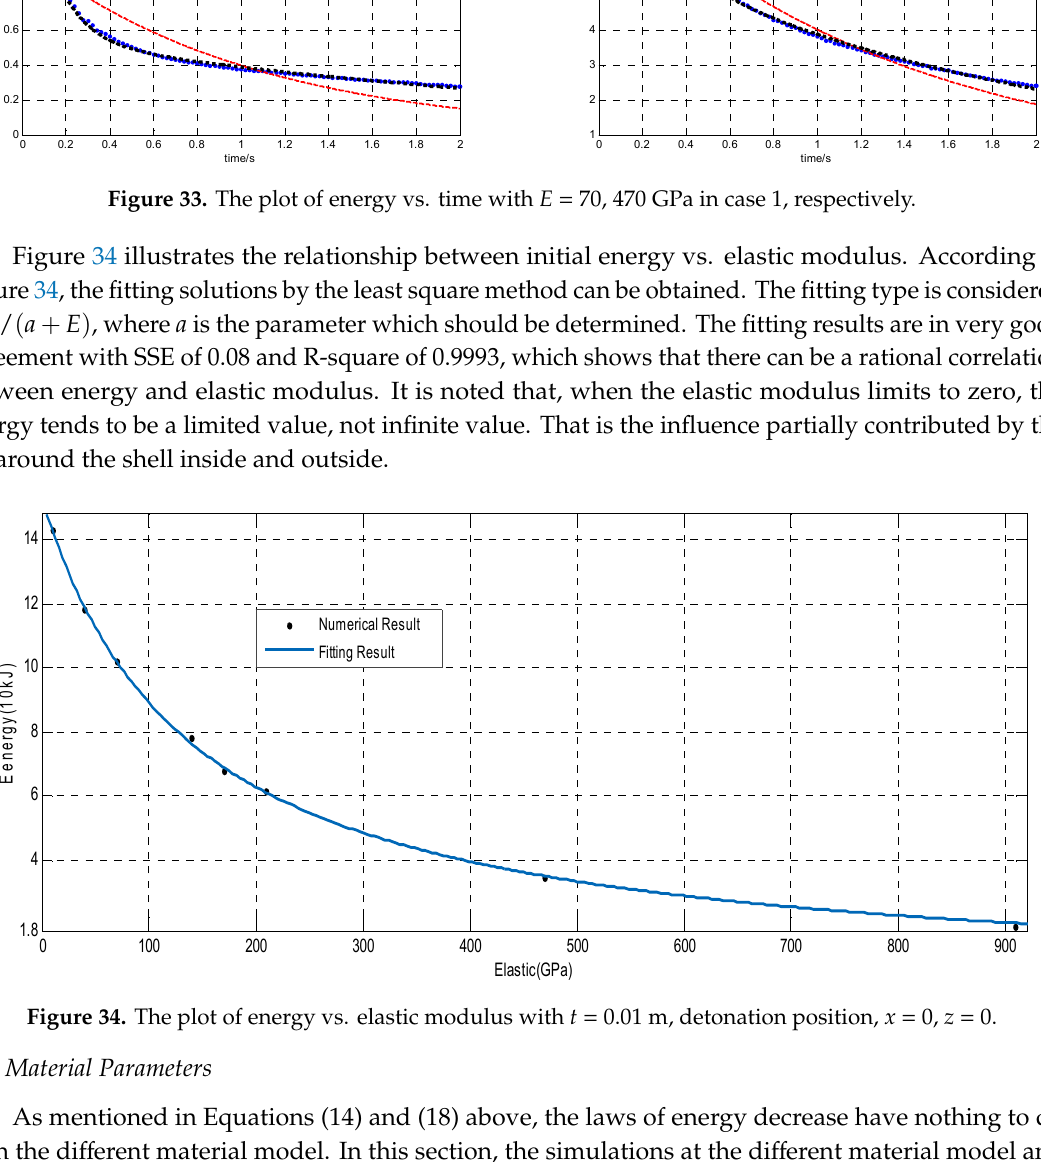
Table 5. Simulation results at plastic kinematic model.